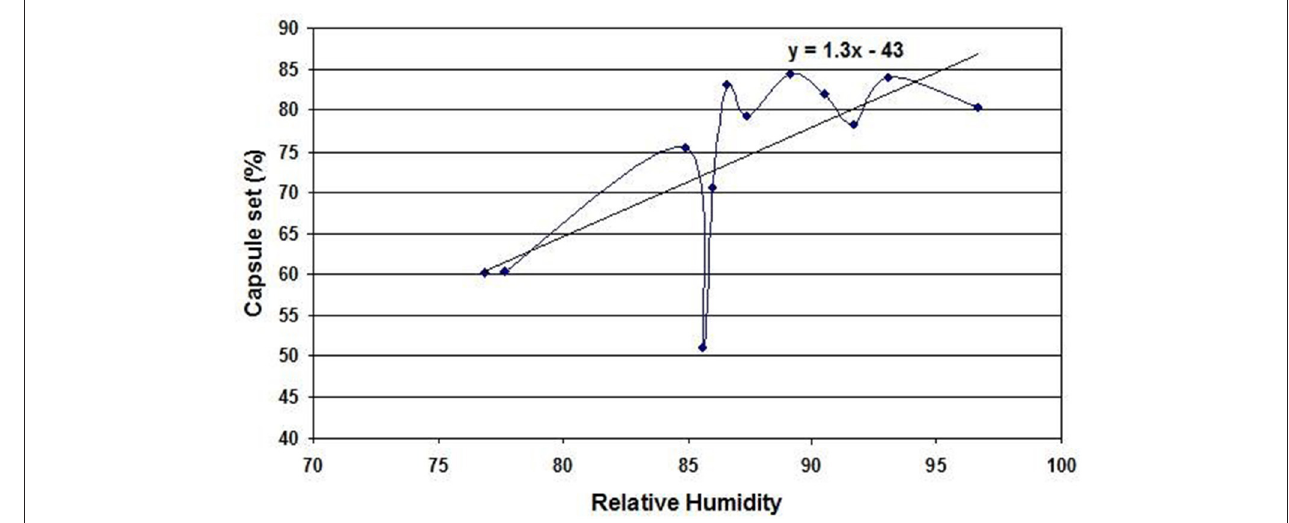
FIGURE 5 | Trend and influence of relative humidity on cardamom capsule set (%).